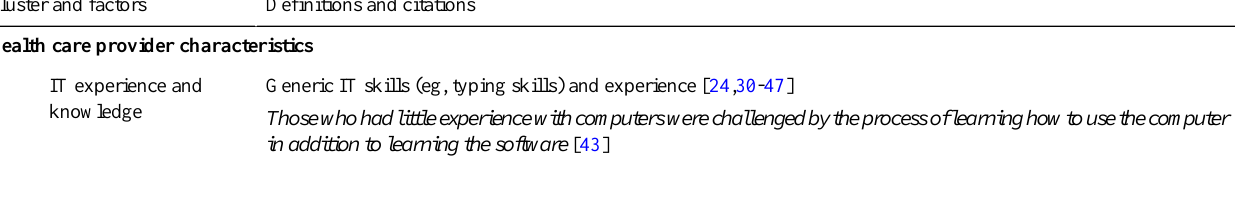
Definitions and citationsCluster and factors